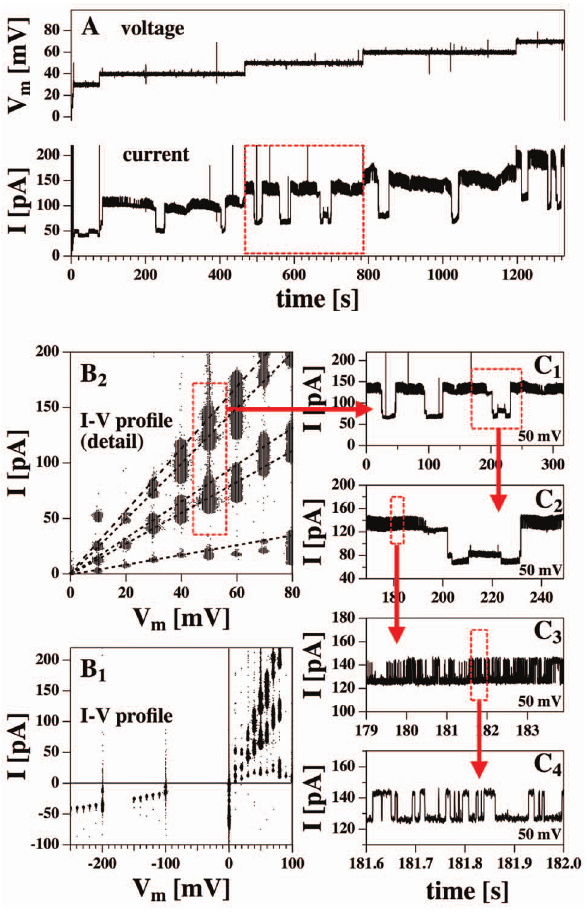
Figure 2. Current-voltage behavior of a different preparation of a DMPC:DLPC=10:1 mol:mol membrane at 30 6 C showing many channel events. A: Section of the raw voltage and current traces (20 minutes out of 1 hour recording). The section in the red box is amplified in panel C 1 . B 1 : I–V profile of the complete data set. At positive voltages one can recognize * 5 individual current levels. B 2 : Amplified section of panel B 1 . The black dashed lines are guides to the eye to mark the five current levels. The red box marks the four current levels that can be seen in panel C 1 . C 1 : Current I at V m =50 mV over 5 minutes. Panels C 2 –C 4 : Consecutive enlargement of small sections of the profile in panel C 1 . In panel C 4 , two individual currents levels can easily be recognized. These two levels are investigated in more detail in Fig. 3.